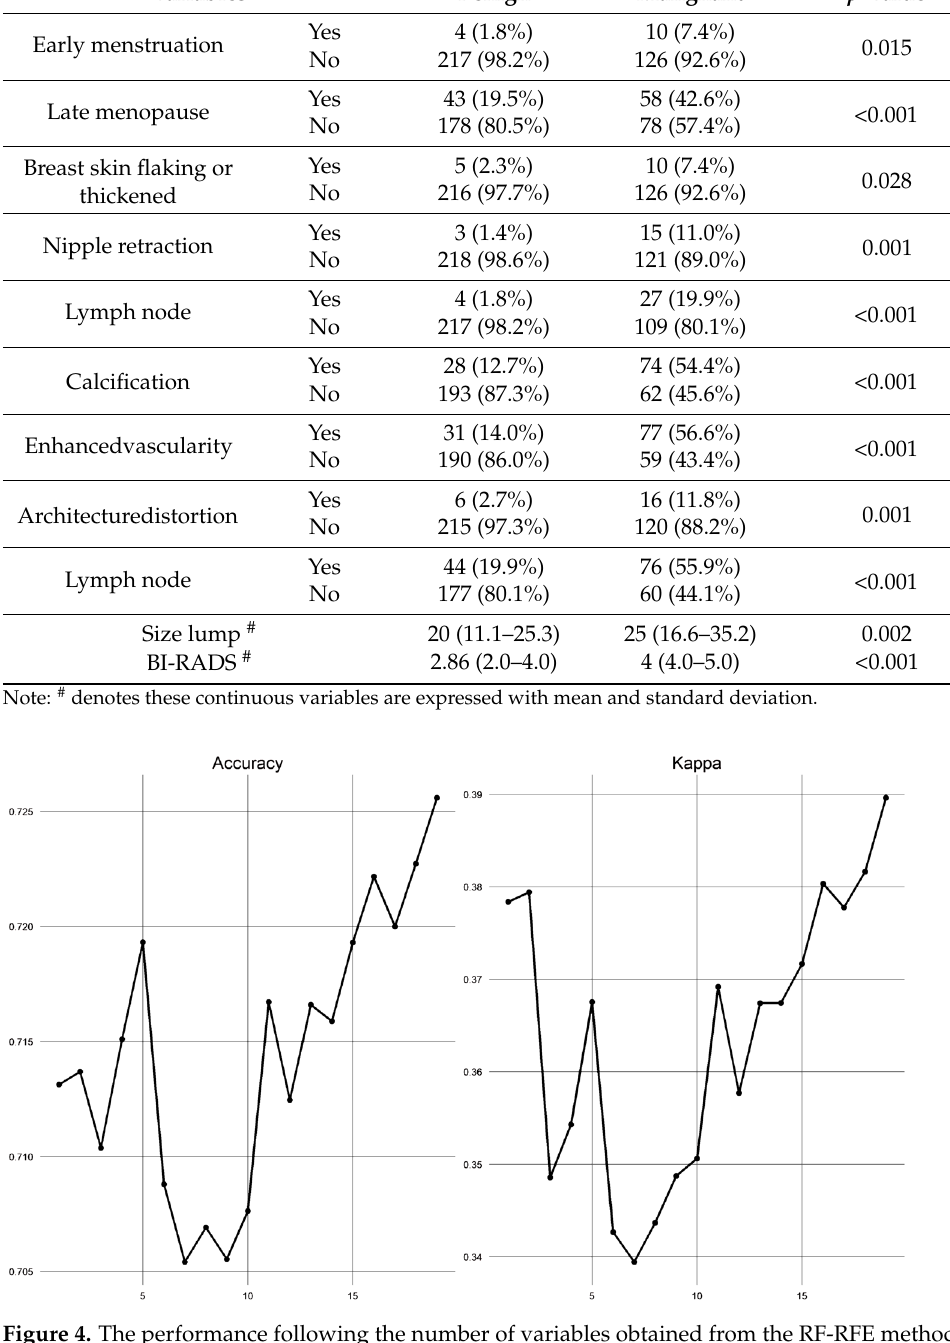
Table 3. The correlation between clinical variables with outcomes which are benign or malignant.